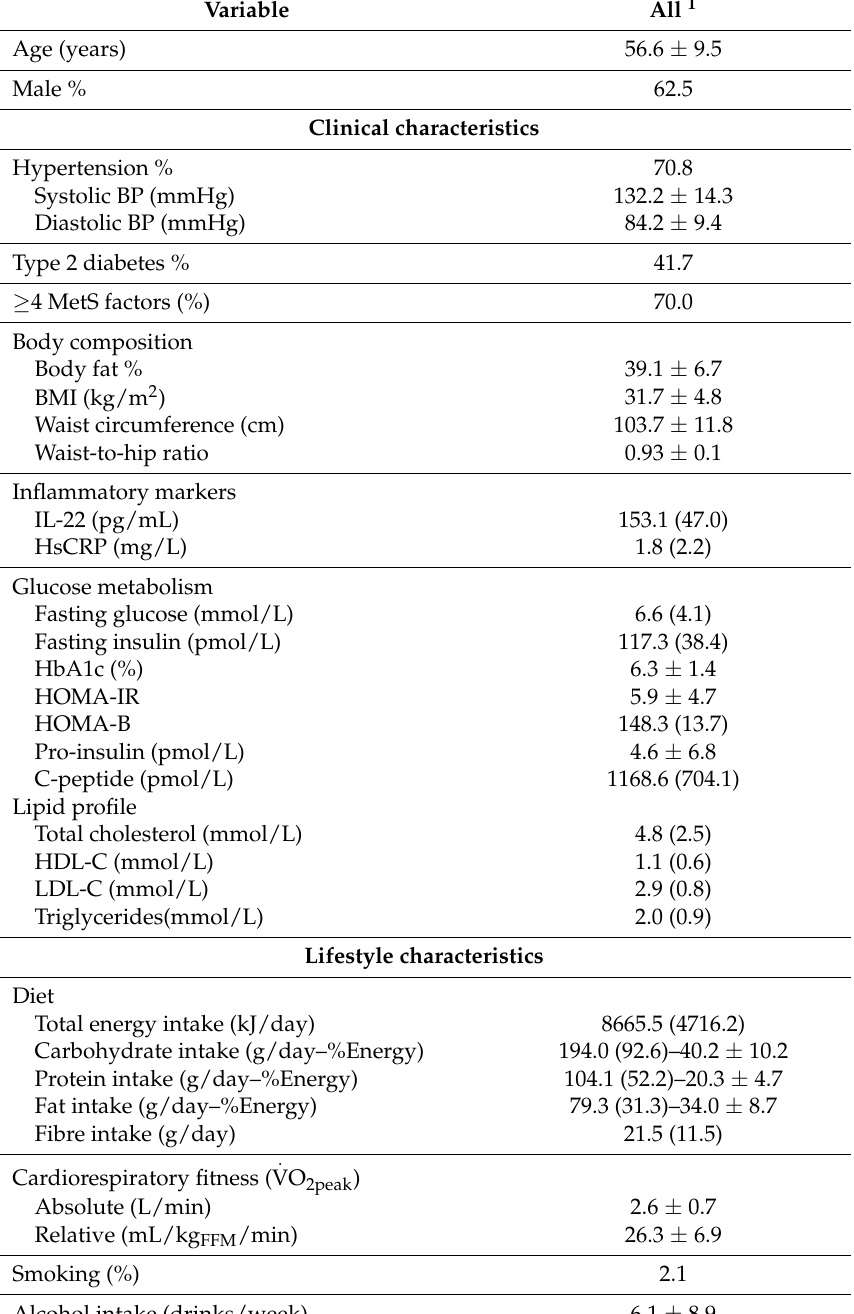
Table 1. Participants demographic, clinical, and lifestyle